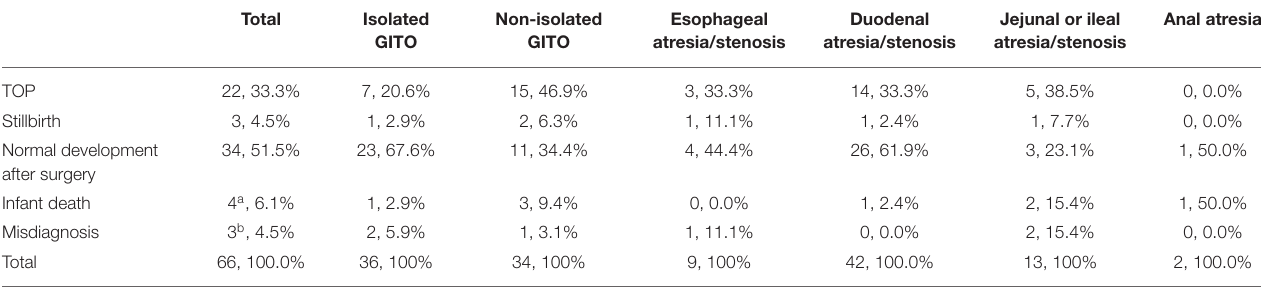
TABLE 4 | Follow-up information for 66 pregnancies with GITO. Total Isolated